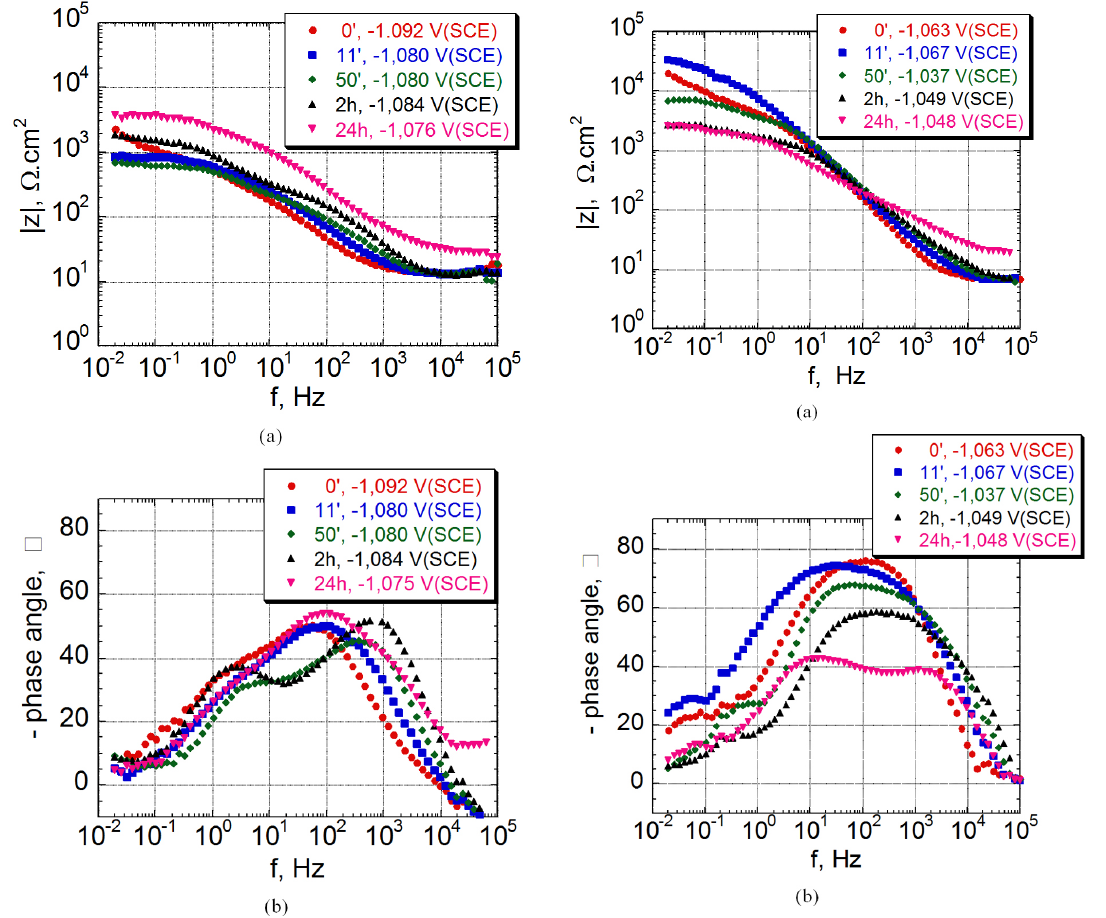
SO , pH 10, solution, for 2 4